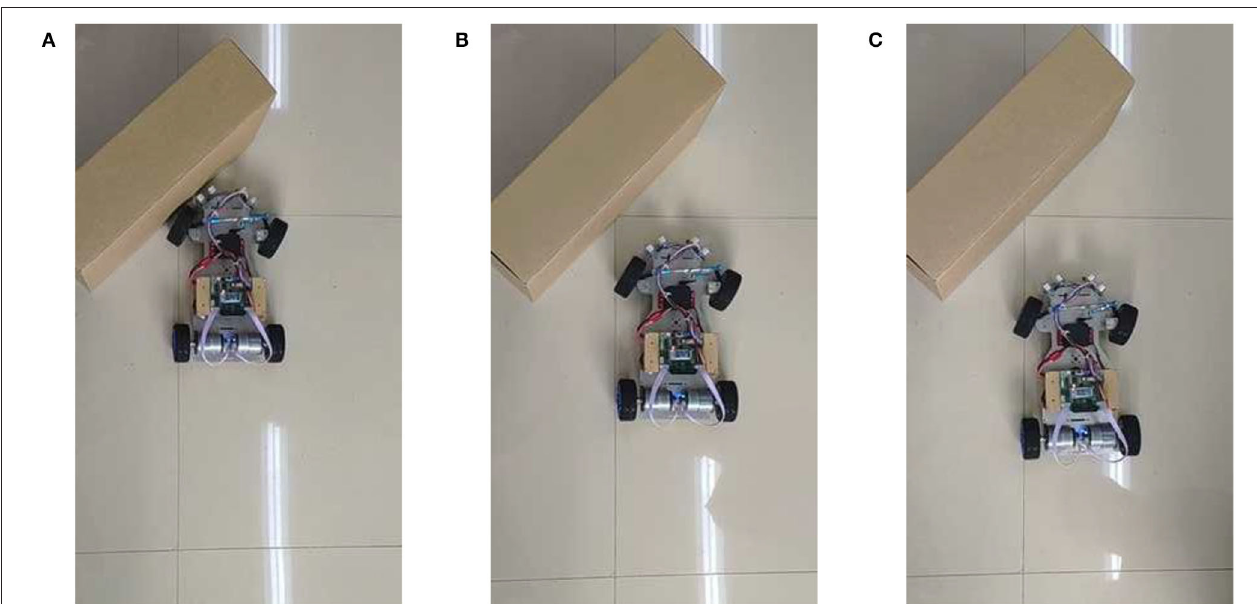
FIGURE 7 | The moment when the mobile robot makes a steering decision in three learning, where (A–C) are the first learning, the second learning, and the third learning, respectively.